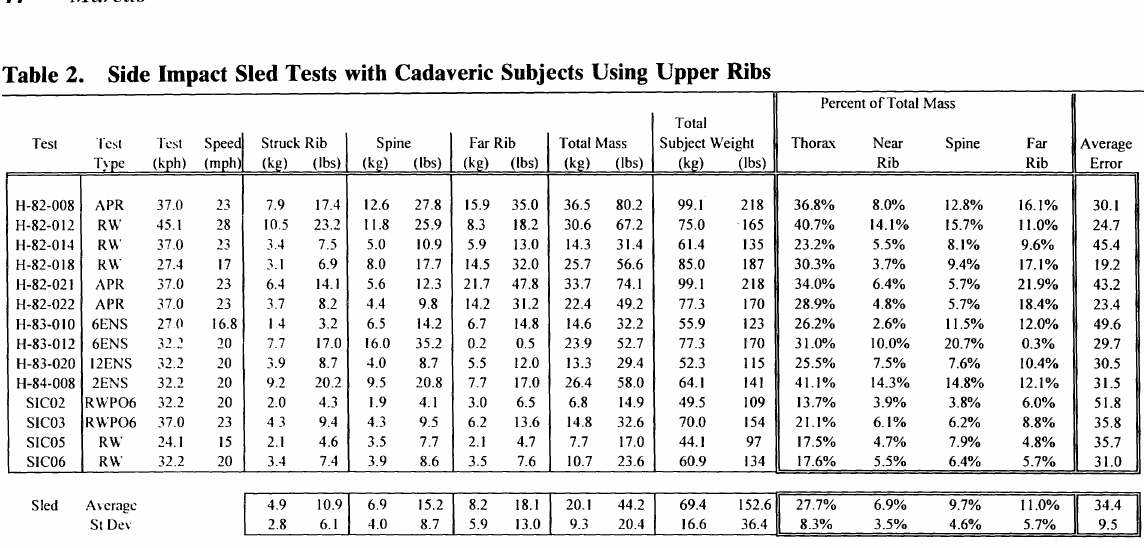
Table 2. Side Impact Sled Tests with Cadaveric Subjects Using Upper Ribs